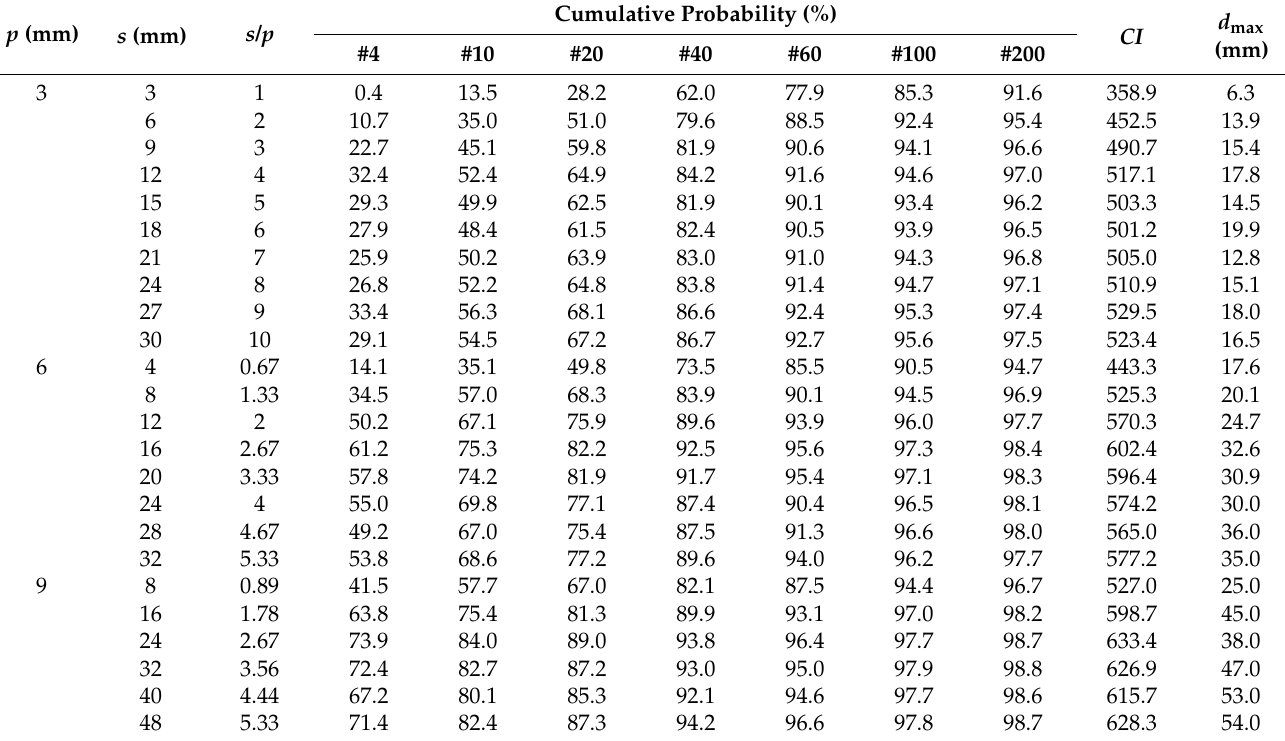
Table 3. Chip size distribution and maximum diameter for model rock of UCS 20